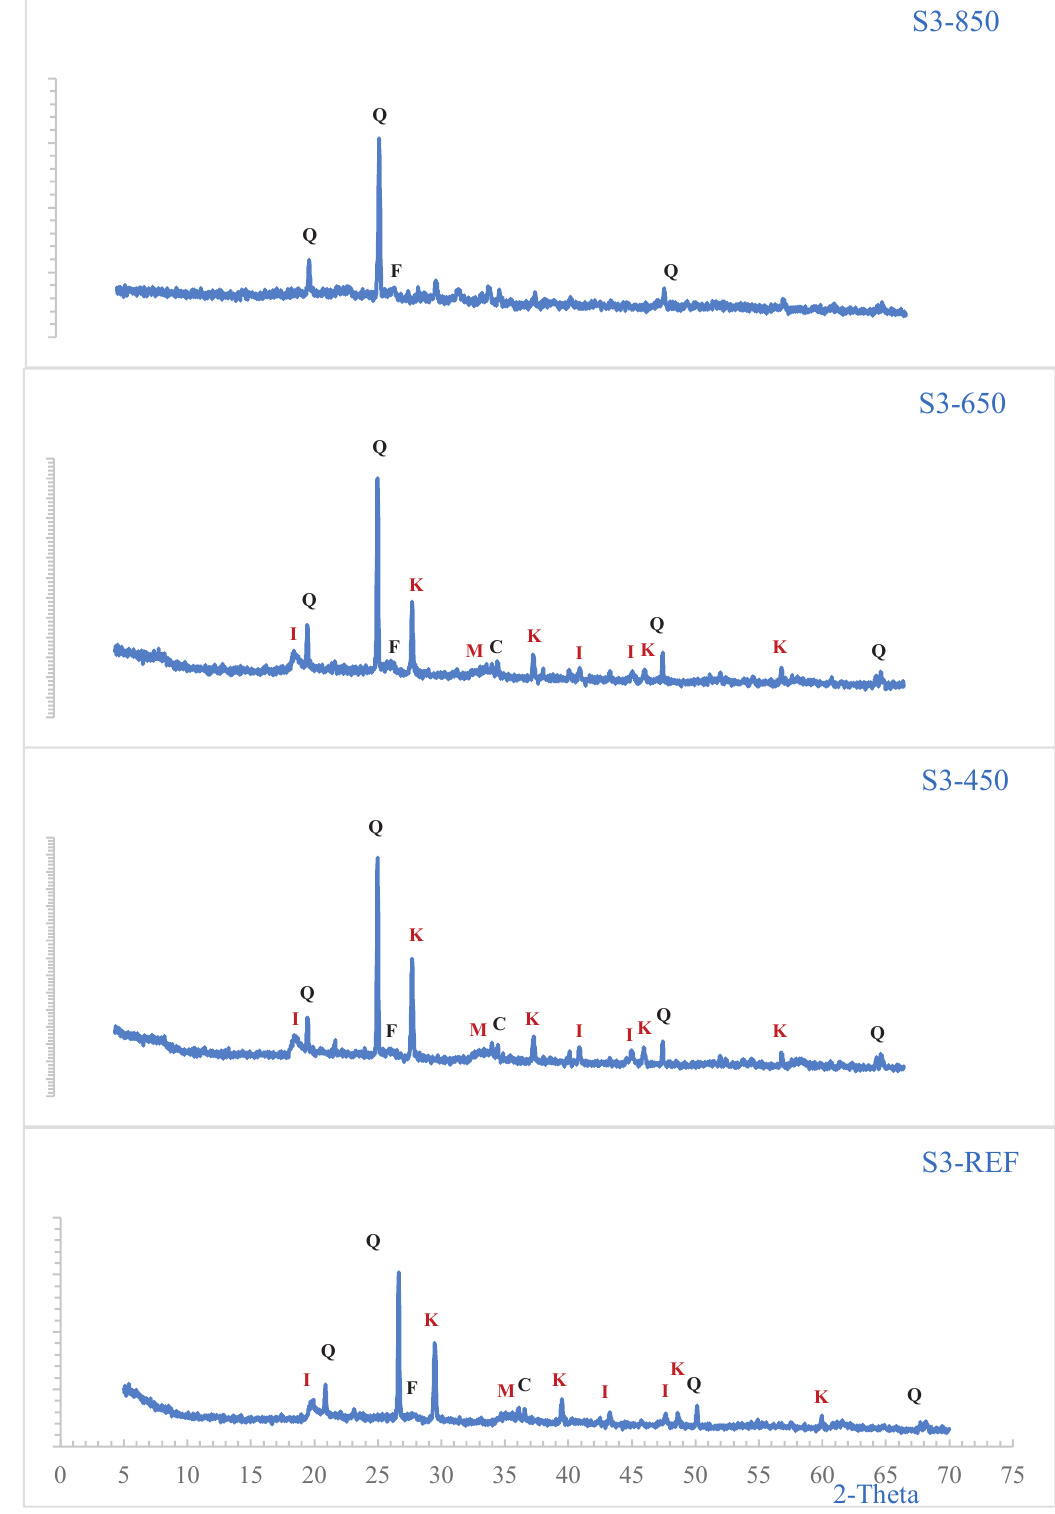
Figure 5. XRD analysis of the soil S3 before and after the thermal treatment (I: illite; Q: quartz; M: montmorillonite; K: kaolin; F: feldspar; C: calcite).